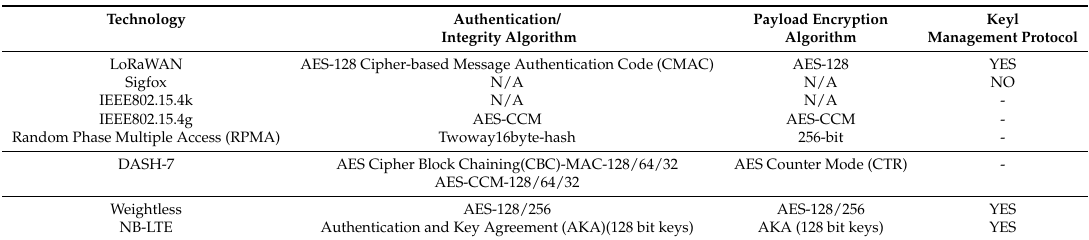
Table 1. Crypto suites used by LP-WAN technologies to authenticate and encrypt the frames. Technology Authentication/ Payload Encryption Keyl Integrity Algorithm Algorithm Management